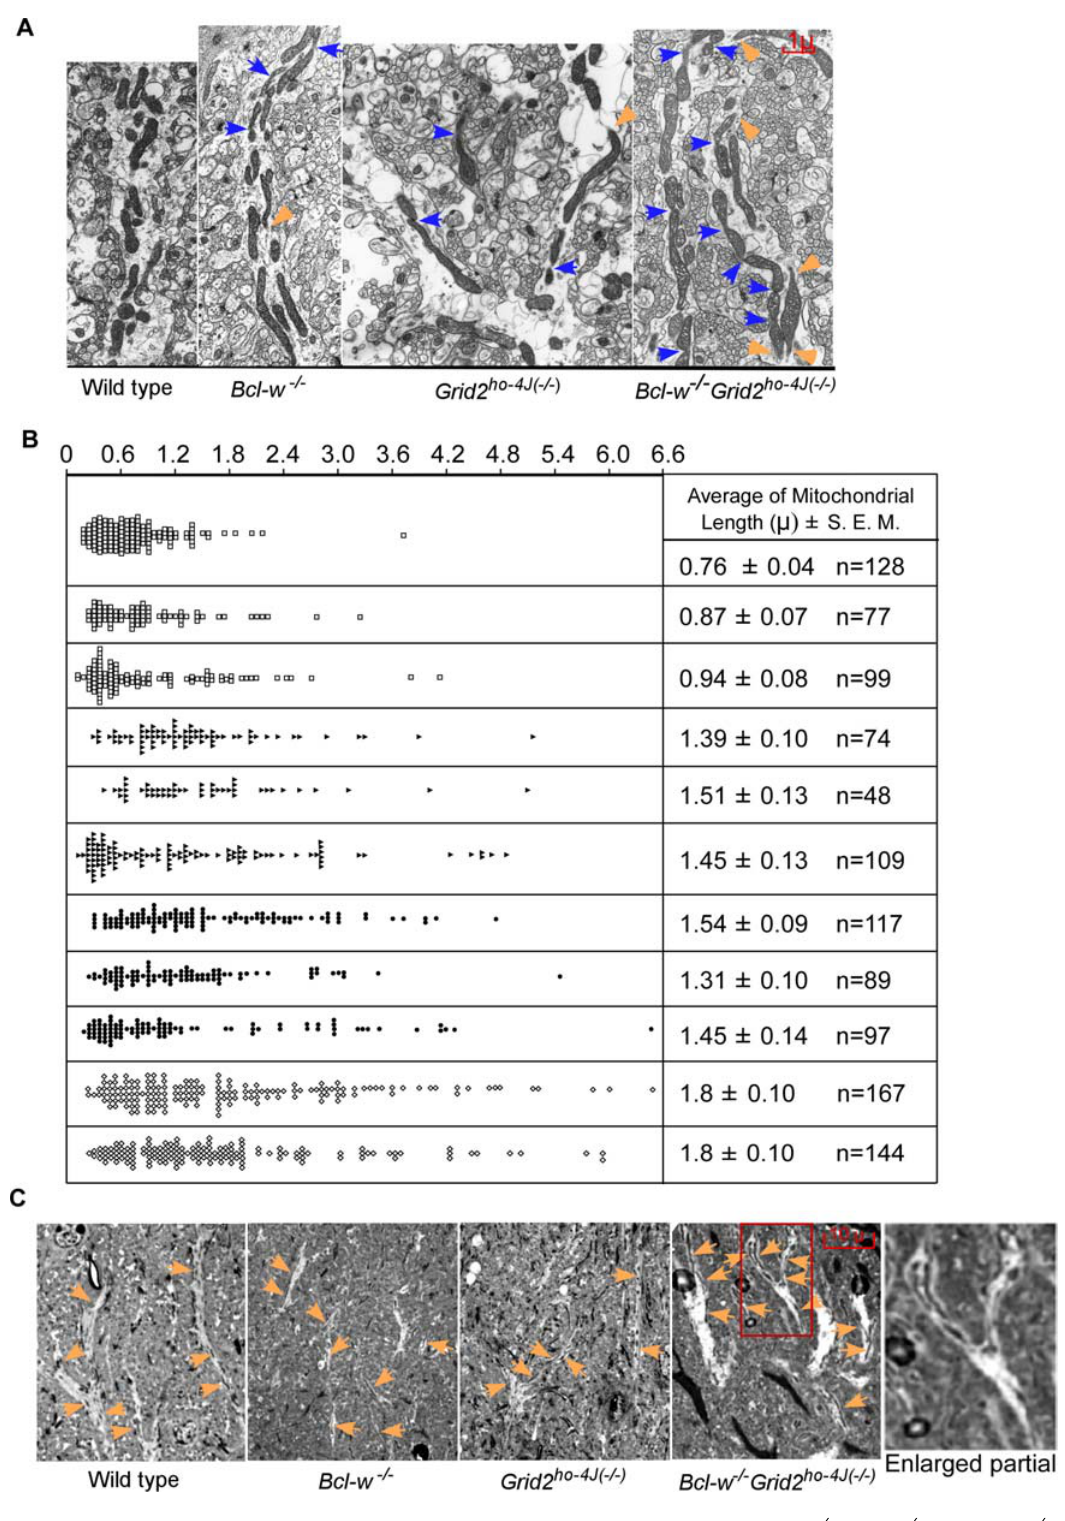
Figure 1. Mitochondrial Morphology Abnormality in Purkinje Cell Dendrites of Bcl-w 2 / 2 , Grid2 2 / 2 , and Bcl-w 2 / 2 Grid2 ho 2 4J/( 2 / 2 ) Mice. (A) Electronmicrograph to show the morphology of mitochondria in dendritic track in wild type, Bcl-w 2 / 2 , Grid2 2 / 2 , and Bcl-w 2 / 2 Grid2 ho 2 4J/( 2 / 2 ) mice. Black arrows indicate dendritic spines, orange arrowhead the broken end of mitochondria, indicating mitochondria transiting out of section plate, and the blue arrows the constriction sites on mitochondria. (B) Histograph showing the length of mitochondria in Purkinje cell dendrites. Each lane represents one mouse. Square indicates wild type mice, solid triangle the Bcl-w 2 / 2 mice, solid dot the Grid2 2 / 2 mice, and diamond the Bcl-w 2 / 2 Grid2 ho 2 4J( 2 / 2 ) mice. A student t-test was performed on mitochondrial length among all listed mice. Three wild type mice are significantly different from all other mice in mitochondria length, p , 0.0001. The mitochondrial lengths in two Bcl-w 2 / 2 Grid2 ho 2 4J( 2 / 2 ) mice are significantly different from